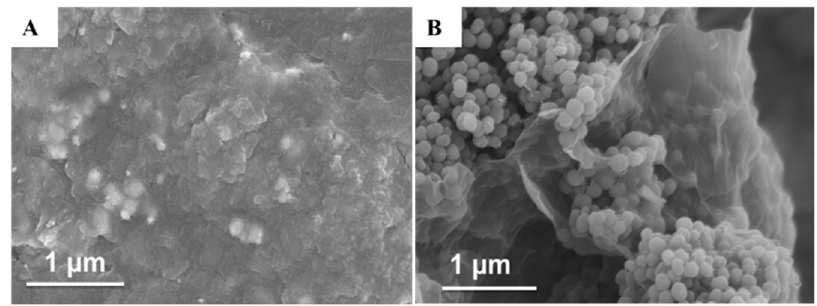
Figure 3. SEM images of rGO/PtNi ( A ) and rGO/PANI@PtNi ( B ).